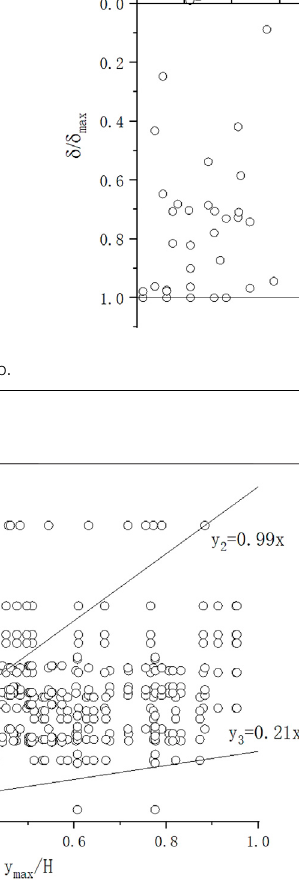
FIGURE 10 | δ max /H- y max /H